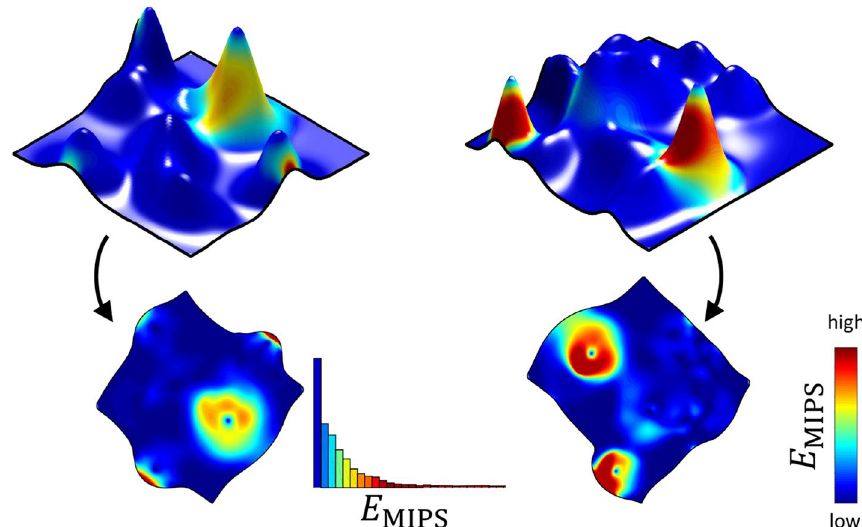
Fig. 4 Flattening surfaces and measuring the resultant geometrical distortions, attained as shape descriptors. The process is visualized for the MIPS distortion energy, defined by (7). We first use ABCD algorithm [2], initialized with Tutte embedding, to map the triangulated surfaces into the plane. We then compute the Jacobian singular values σ 1 ( t ) and σ 2 ( t ) over each mesh triangle t . Finally, we compute for each distortion measure E (σ 1 , σ 2 ) and mapping f the two quantities E 1 ( f ) and E 2 ( f ) , defined according to (11) and